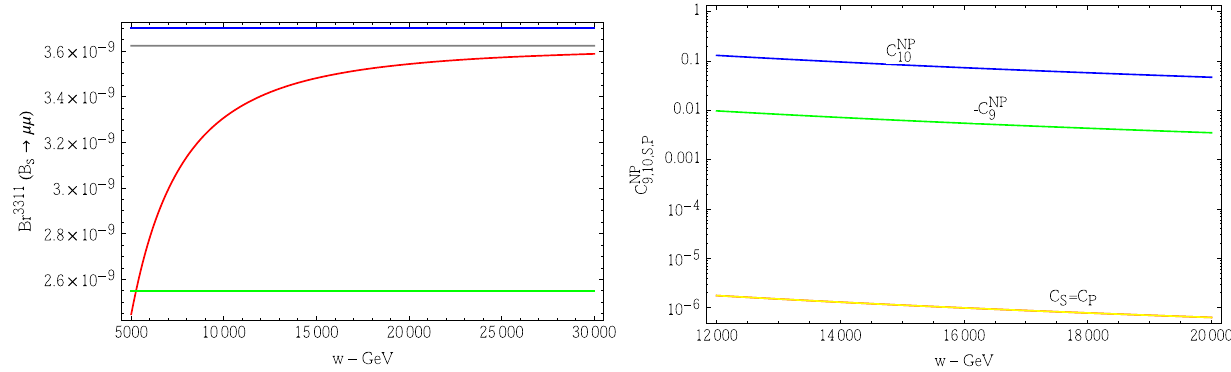
contributions to the Wilson coefficients. Here both panels are plotted by fixing: (cid:12) = 1000 w, f = − w, u = 200 GeV. Other parameters are selected as done in the Sect.